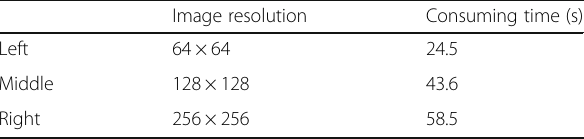
Table 1 Consuming time of different resolution images in Fig.